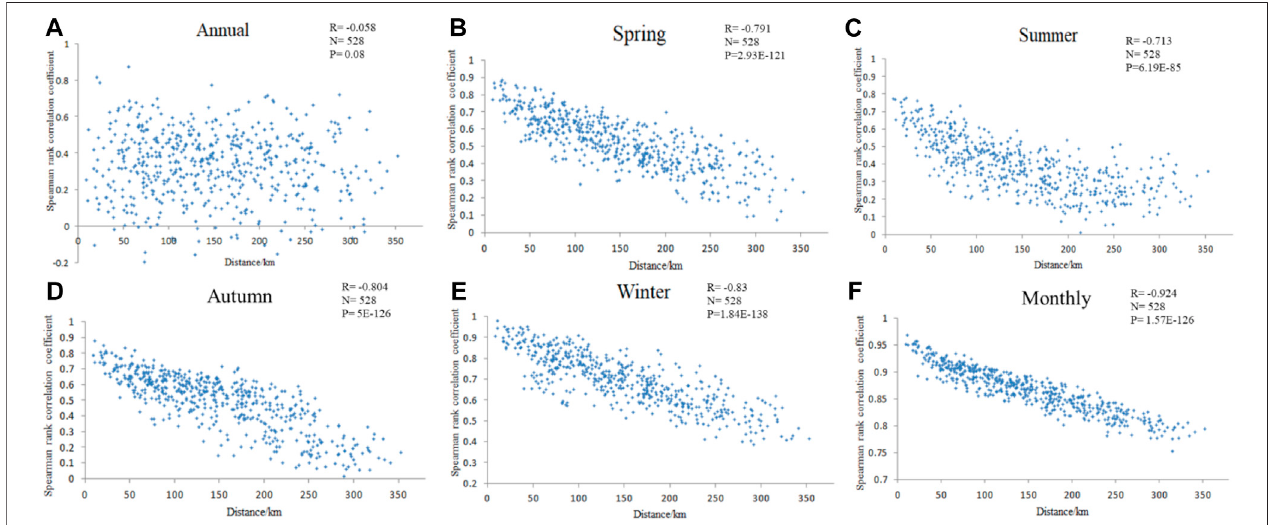
FIGURE 2 | Spatial correlation of rainfall stations at different time scales (A : Annual, B – E : Seasonal, F : Monthly ) .